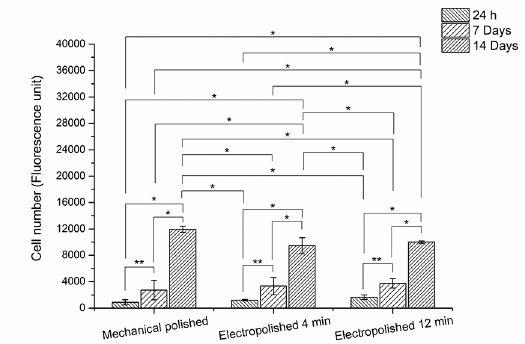
Figure 6. Average number of cells per sample after cell growth in non-osteogenic media. *p < 0.05, **p <